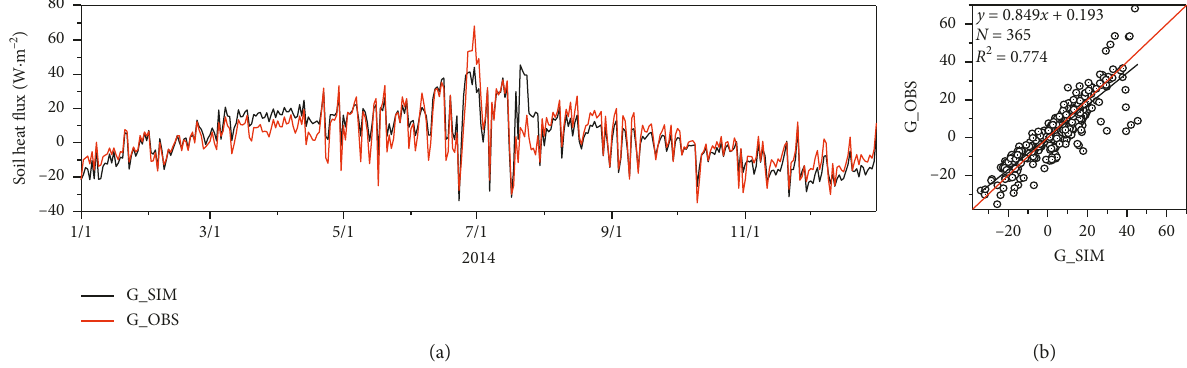
Figure 9: Contrast curve (a) and scatter plot (b) of the simulated (black) and observed (red) soil heat flux ( G